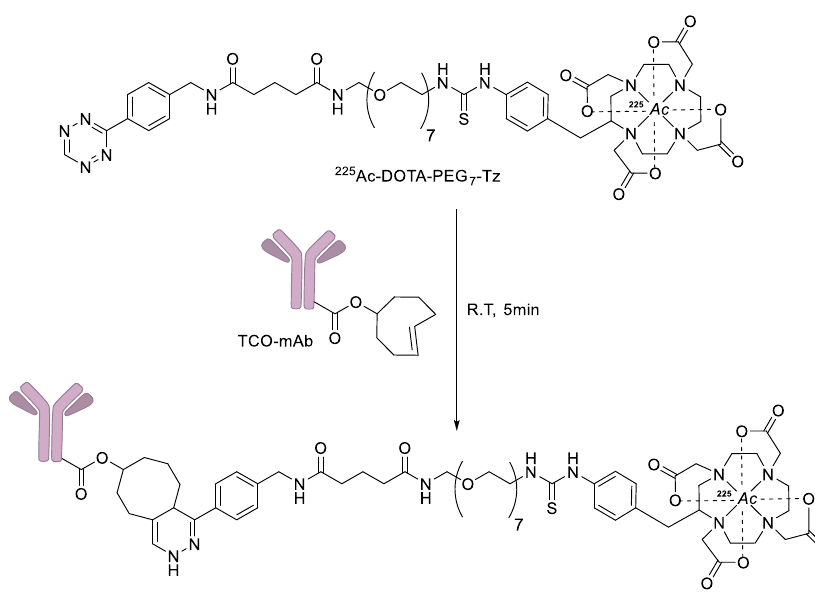
Figure 11. IEDDA-mediated synthesis of 225 Ac-labeled monoclonal antibody.